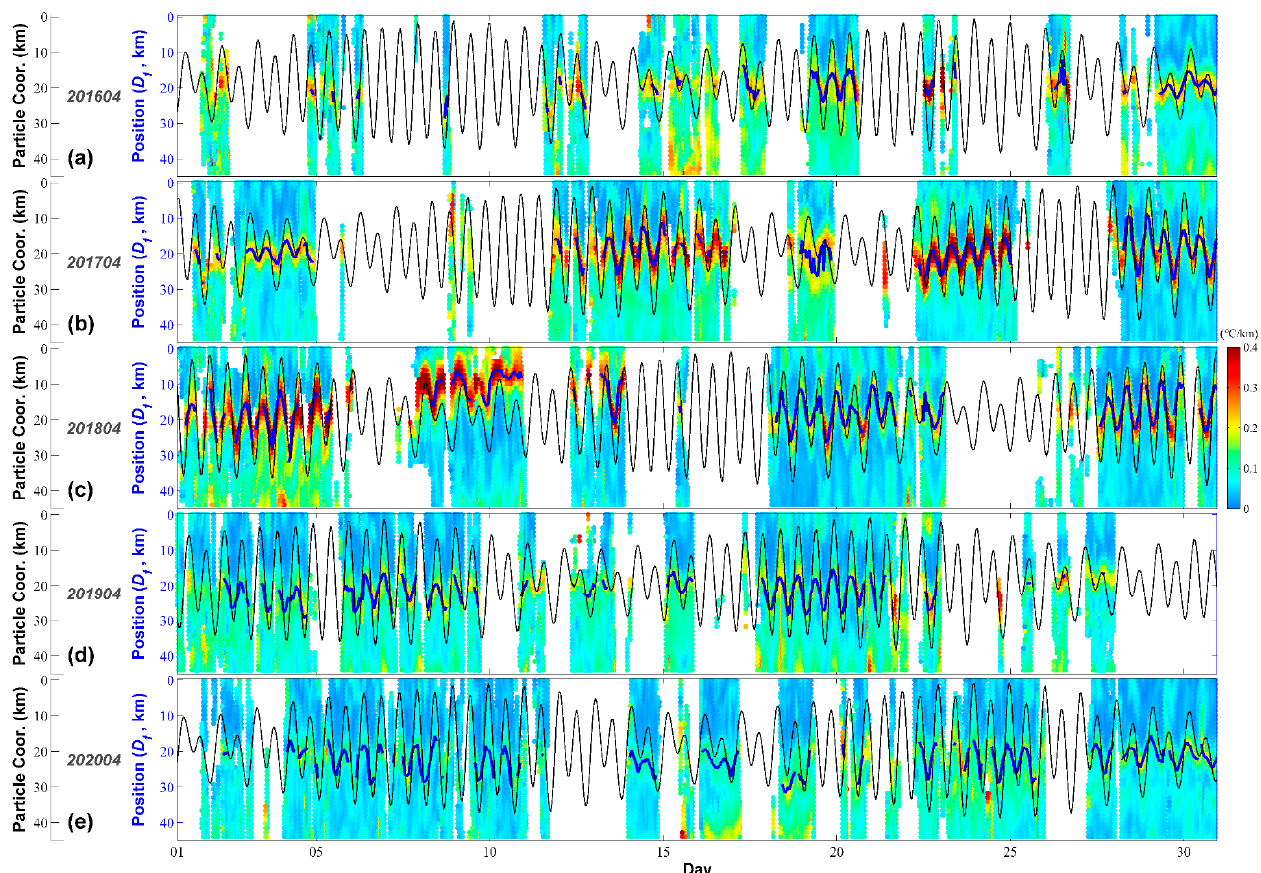
Figure 6. Time series of the front position ( D f , distance between the point denoted by a star and the center of the strait (thick blue line) in Figures 3 and 4), the particle coordinator calculated by the predicted tidal current velocity using Equation (2) (black line), and the magnitude of the SST gradient along the line passing through the star in Figures 3 and 4 and the center of the strait (color) in April from 2016 ( a ) to 2020 ( e ).